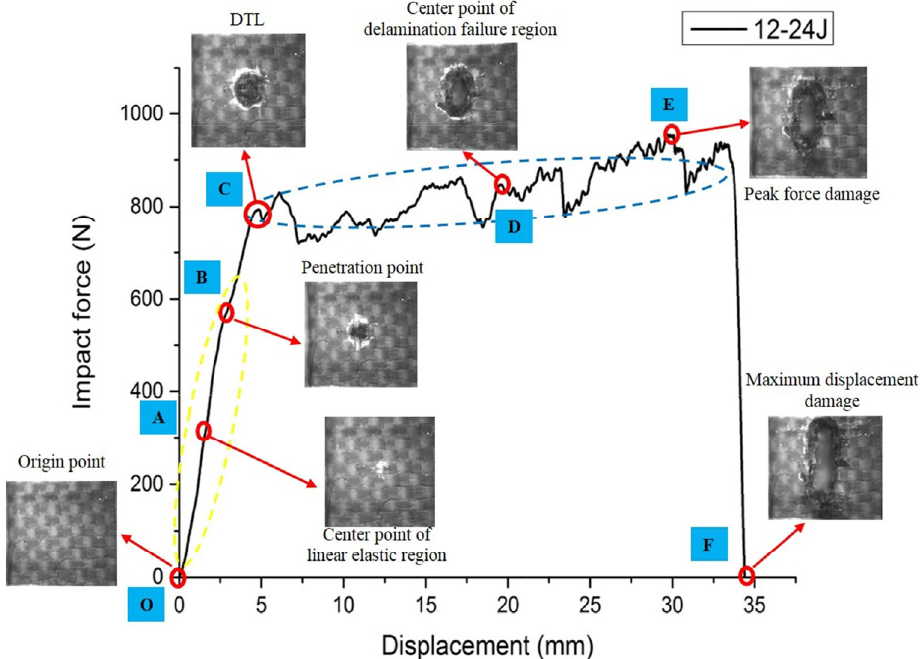
Figure 3. Measured characteristic points and local failure modes of 12-layer composite on the impact force-displacement curve at 24 J impact energy, combined with high-speed camera images of characteristic points. DTL means delamination threshold load. Reprinted from [33], Copyright (2022), with permission from Elsevier.